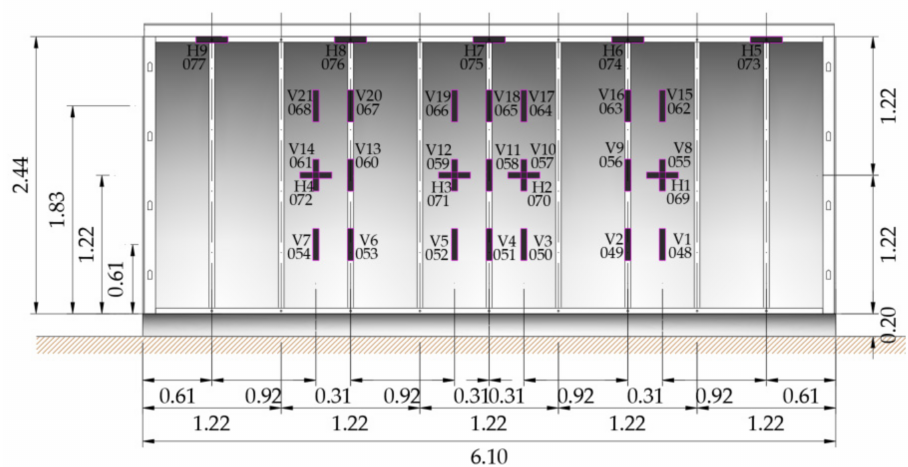
Figure 11. Strain Gauges identification on Wall 1 (west face).